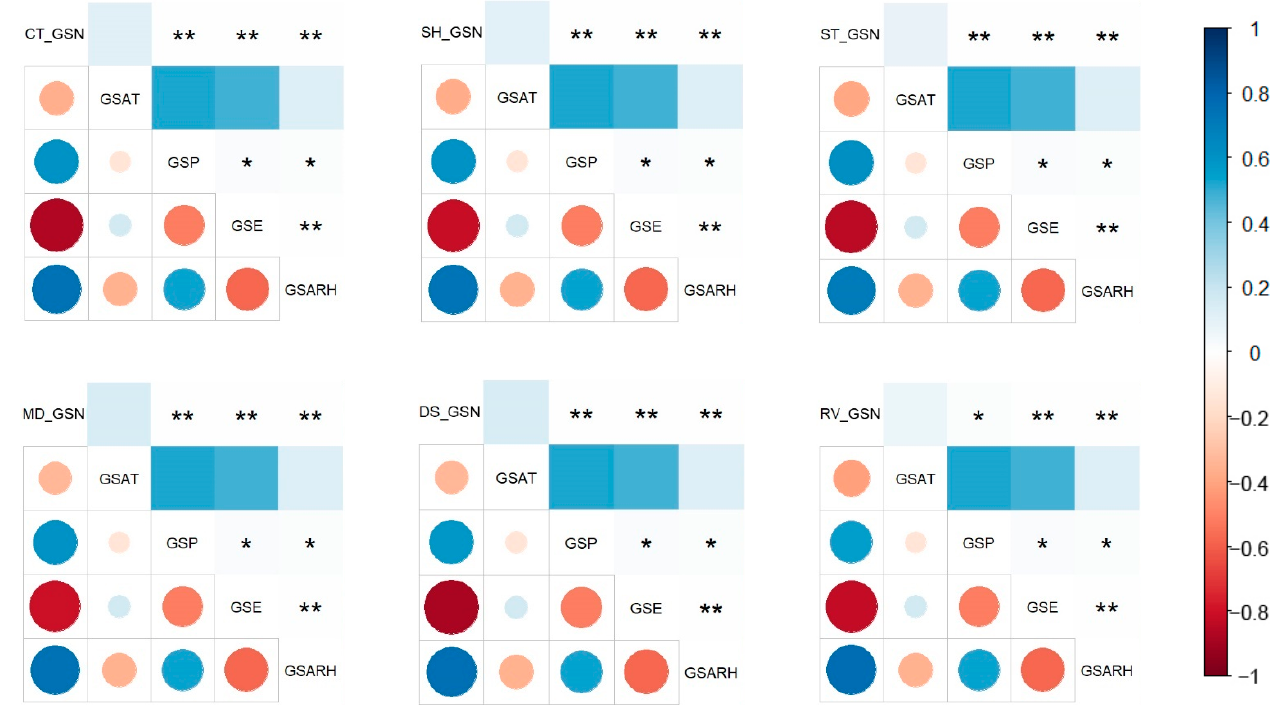
Figure 9. Correlation analysis between growing season NDVI (GSN) and 4 climatic factors over growing season. CT, SH, ST, ME, DS and RV represent county, shrubland, steppe, meadow, desert steppe and rest vegetation, respectively. The symbols below the diagonal were the correlation coefficient, and the symbols above the diagonal were the corresponding significance. * and ** represented a significant relationship at p = 0.05, p = 0.01 level, respectively.